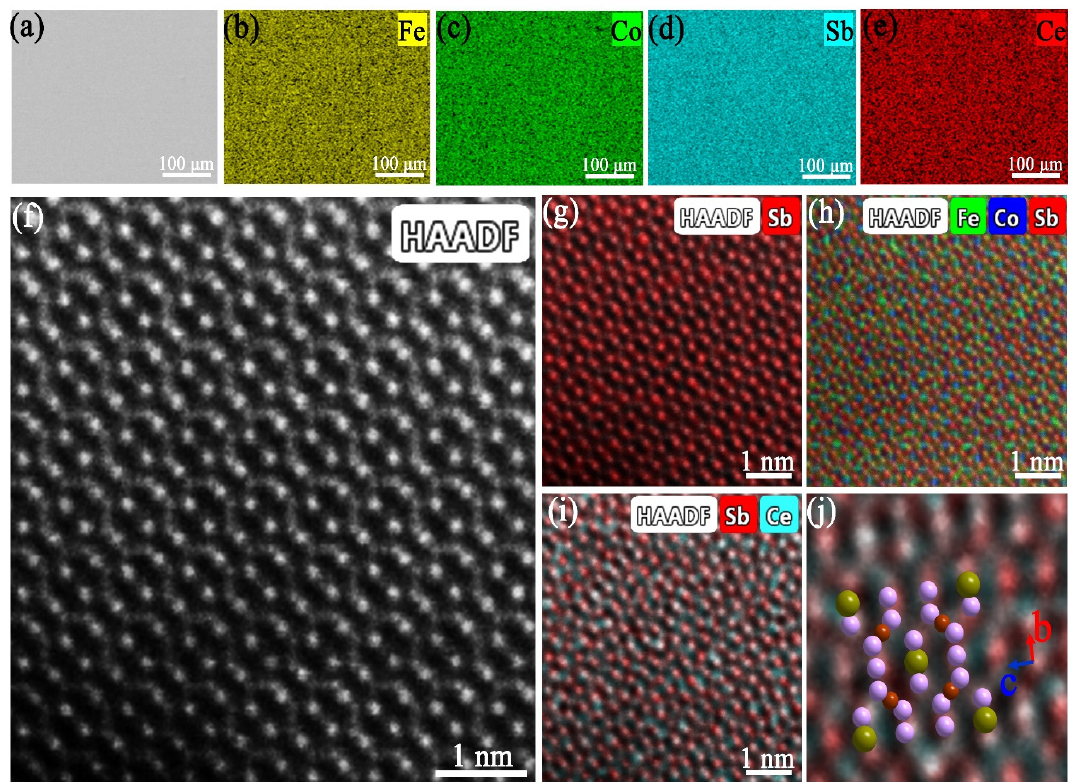
Figure 3. SEM image ( a ), the corresponding elemental maps of Fe ( b ), Co ( c ), Sb ( d ), Ce ( e ) of the Ce 1.25 Fe 3 CoSb 12 sample. The HRTEM HAADF image ( f ) of the CeFe 3 CoSb 12 and the corresponding atomic scale elemental map of Sb ( g ), overlay elemental map of Fe, Co and Sb ( h ), overlay elemental map of Sb and Ce ( i ), the magnified overlap of elemental maps superimposed with the crystal structure ( j ), where the dark green ball, the pink ball and dull-red ball represent Ce, Sb, and Fe/Co.